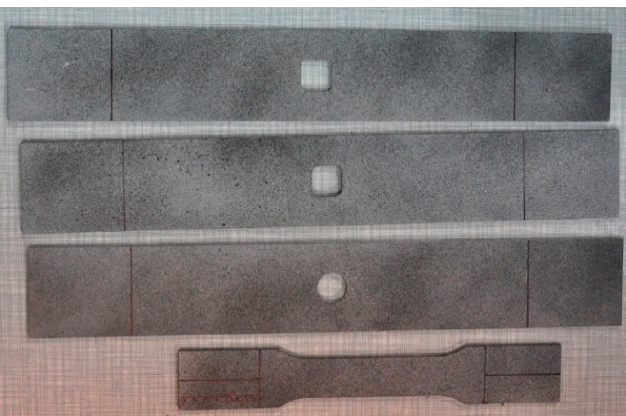
Figure 4. Photograph of tested samples 1–4 covered by speckle patterns.